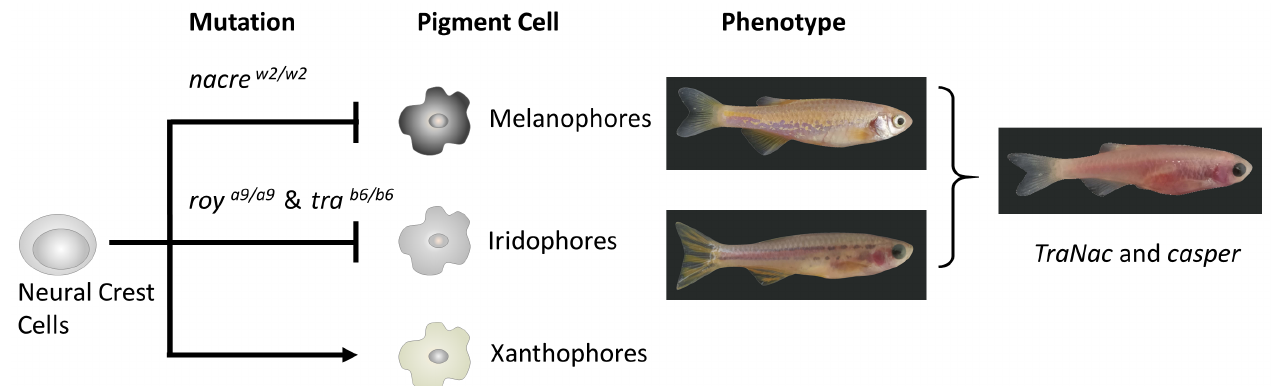
Figure 1. Zebrafish mutants, the affected pigment cells and corresponding phenotypes. The pattern characteristic of Zebrafish colouration depends on three pigment cell types: melanophores, xanthophores and iridophores (Singh & Nüsslein-Volhard, 2015). Mutational inactivation of two of those chromatophores gives rise to transparent zebrafish ( TraNac and casper ) . TraNac = tra b6/b6 ; nac w2/w2 compound zebrafish mutants, nac = nacre, roy = roy orbison, tra = transparent , WT =